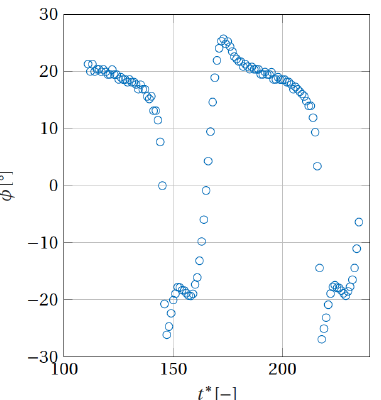
Figure 13. Time evolution of the phase angle between lift force and transverse displacement at U ∗ = 3 . 1. Figure taken from Derksen